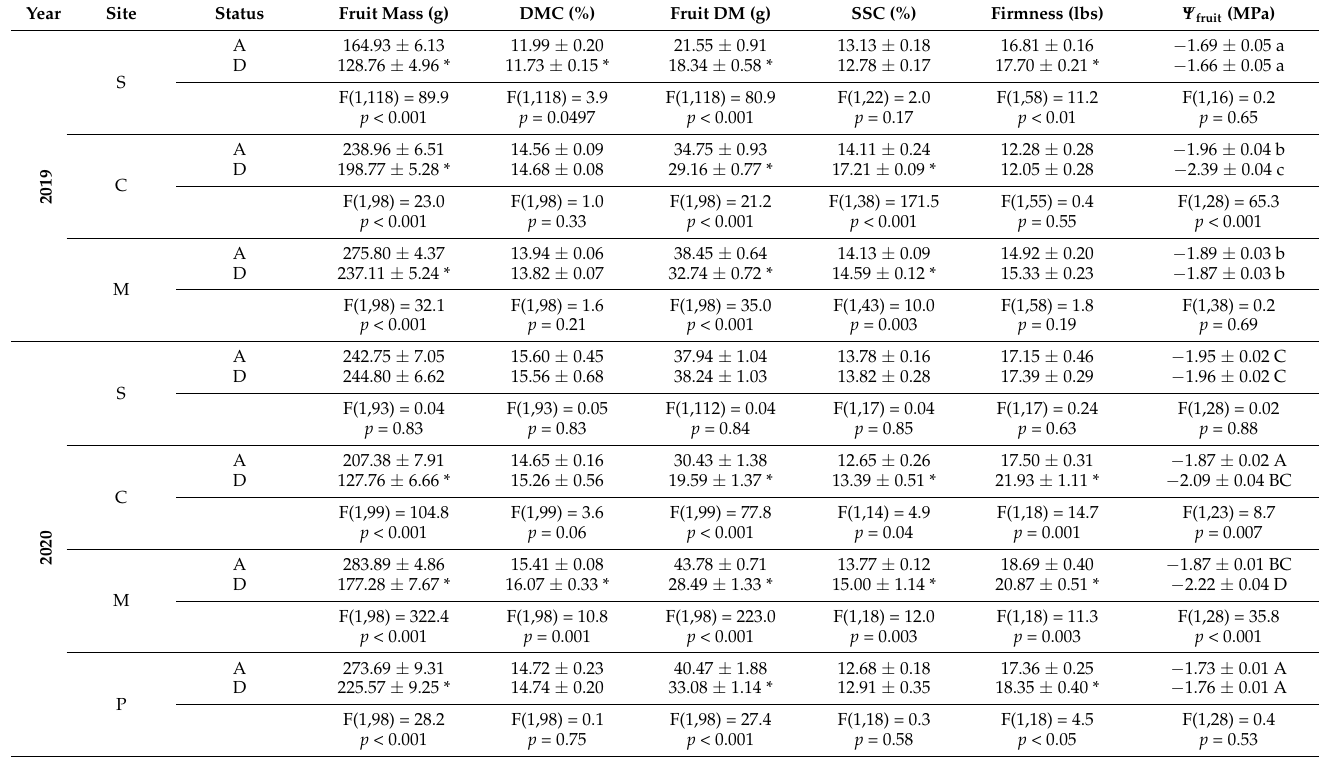
Figure 3. The δ ‰ 13 C composition of leaf tissue collected from asymptomatic and declining trees at Sites A ( n = 4), S ( n = 8), C ( n = 4) and M ( n = 4), in 2019. Values are means ± standard error of the mean. Table 2. Fruit mass, dry matter content (DMC), estimated dry matter weight, soluble solids content (SSC), firmness, and flesh water potential of ‘Ambrosia’ apple on asymptomatic and declining trees, from three sites in 2019 and four sites in 2020.